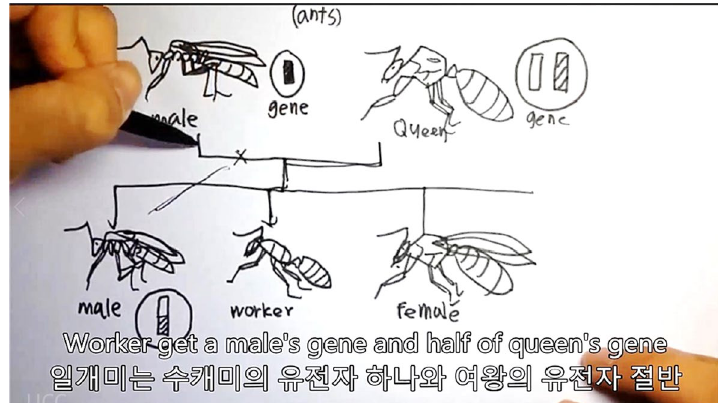
Fig. 1 Hyung Seo’s use of L1, L2, and images in English book review